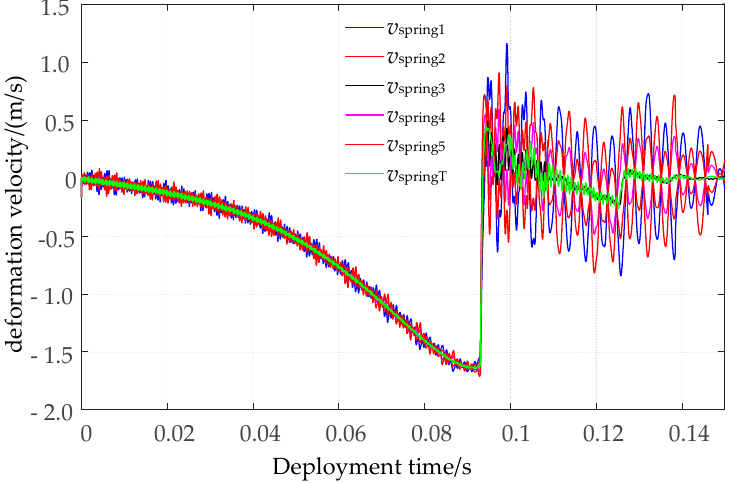
Figure 6. The curves in the deformation velocity of springs and deployment time. The results show that the simulation model of the parallel springs could be replaced by an equivalent spring. The deformation velocity of the springs fluctuates in both the deployment and locking stages. In addition, the fluctuation in the initial phase of the locking stages becomes more significant than in the deployment stage. However, it tends stage with deployment.